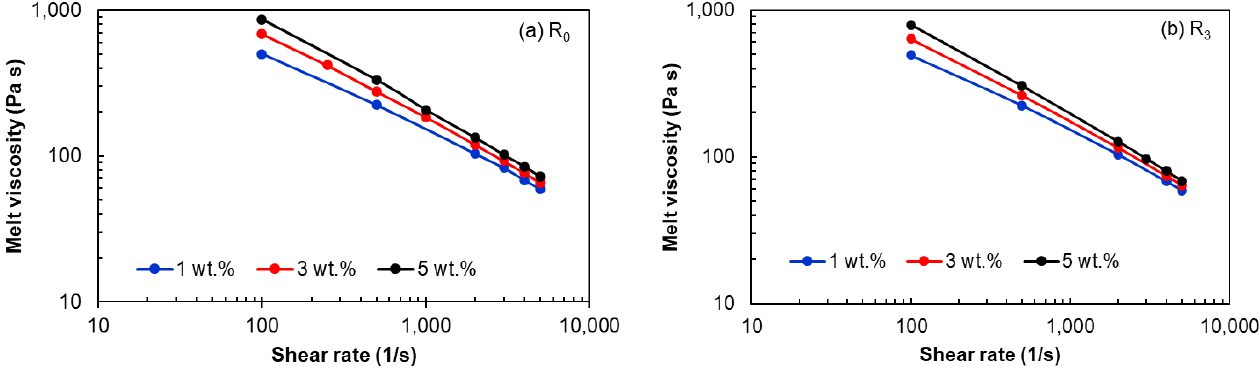
Figure 6. Melt shear viscosity as a function of shear rates and MWCNT wt.% at 160 °C: ( a ) R 0 and ( b ) R 3 .